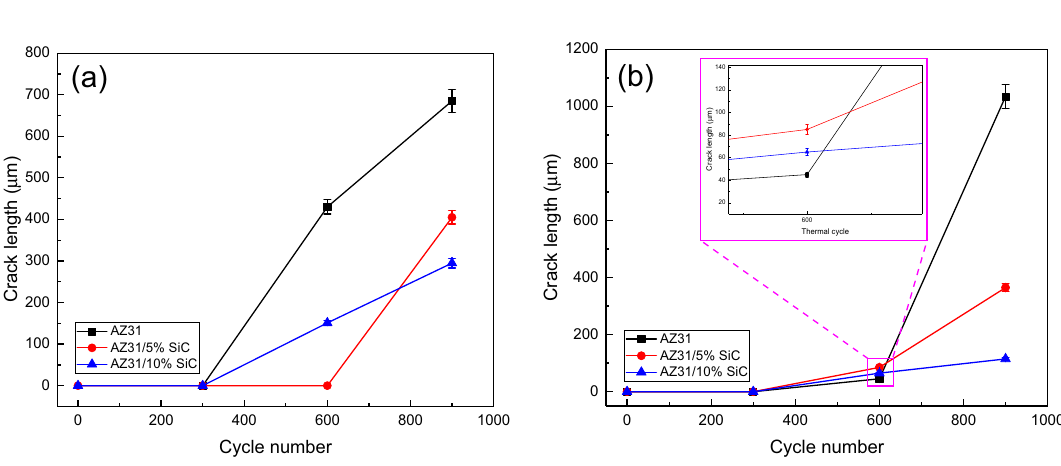
Figure 15. Crack length of the aged samples after thermal cycle at: ( a ) 150 °C, and ( b ) 350